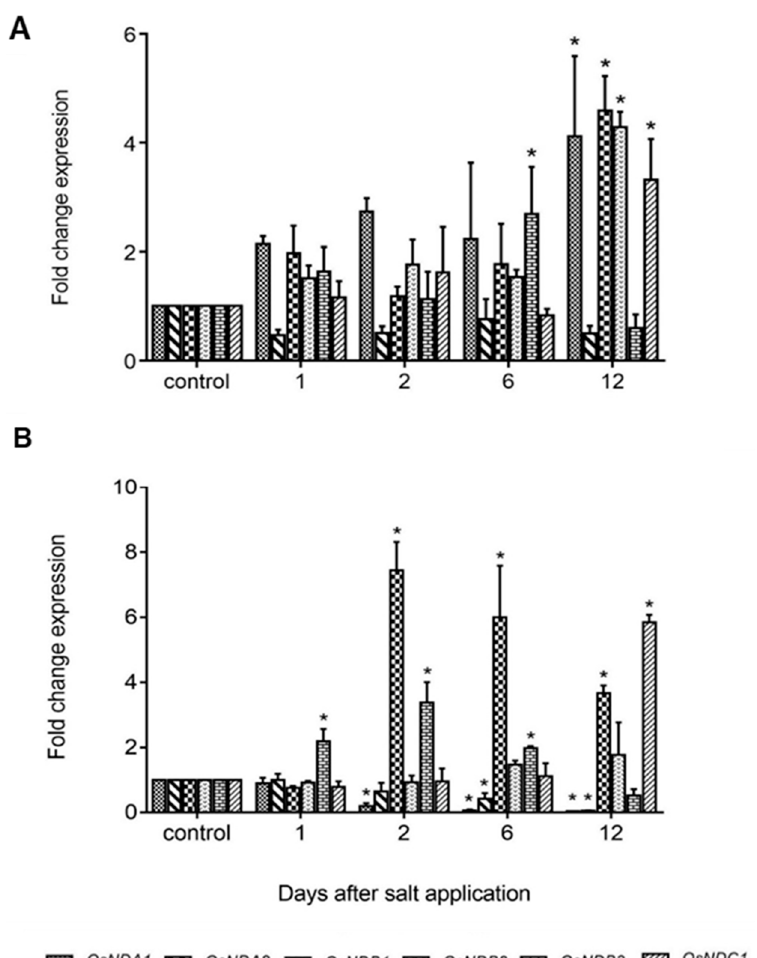
Figure 8. Expression of alternative dehydrogenases (NDs) in rice under salt stress. Fold change expression of ND isoforms, OsNDA1 , OsNDA2 , OsNDB1 , OsNDB2 , OsNDB3 and OsNDC1 , in seedling shoots ( A ) and roots ( B ) were analysed in response to 120 mM NaCl using qRT-PCR over a period of 12 days. Data are shown as the mean ± SE of three biological replicates relative to the control at each time point set as 1.00. Significant differences are indicated by asterisks (*) at p < 0.01 ( t -test).